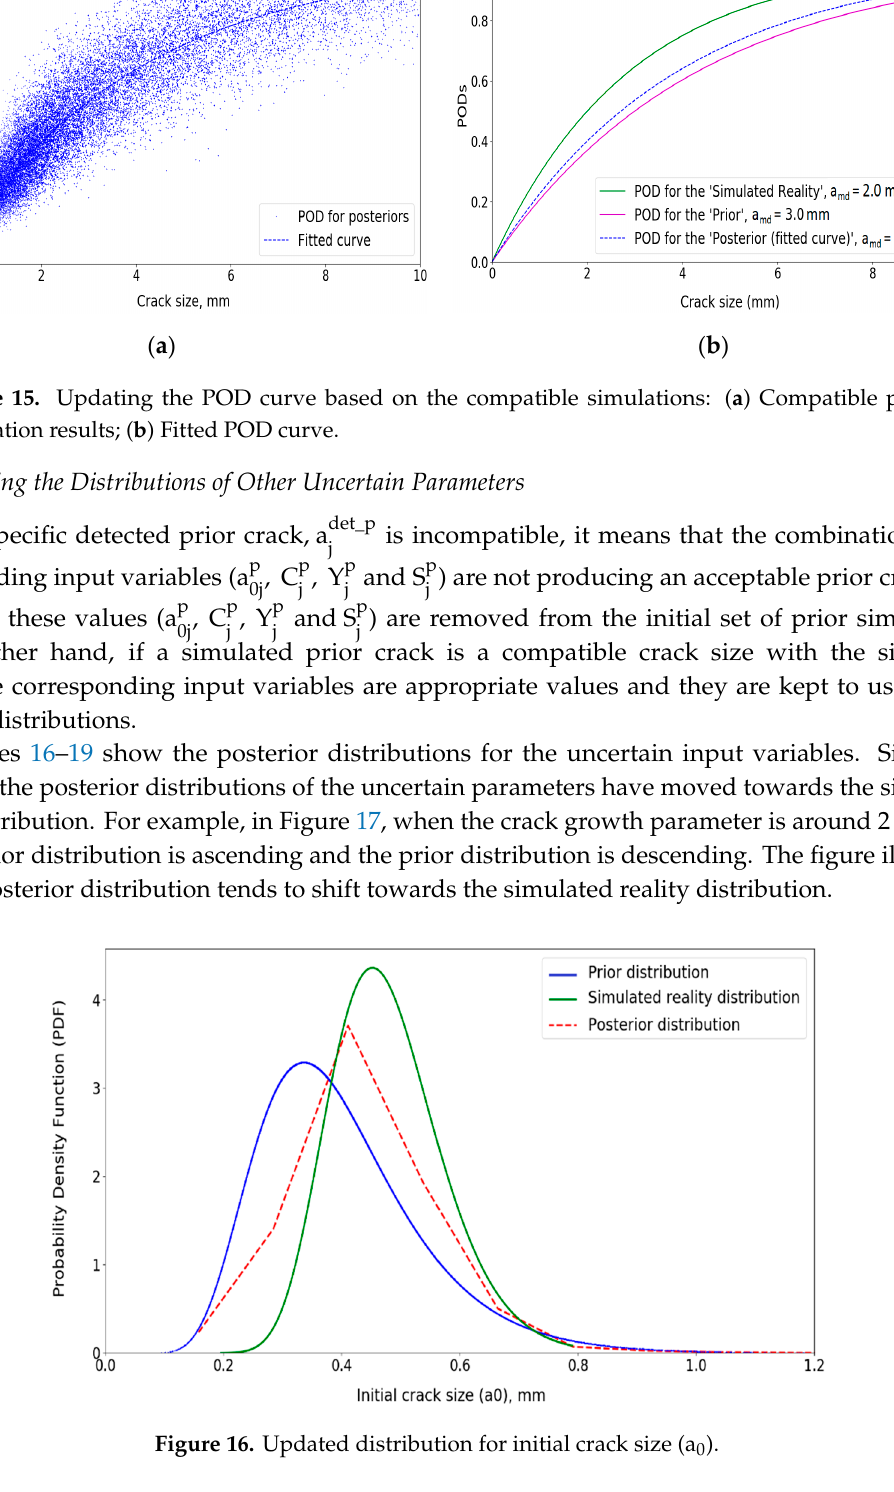
Figure 17. Updated distribution for crack growth parameter (C) Figure 18. Updated distribution for stress range (S)